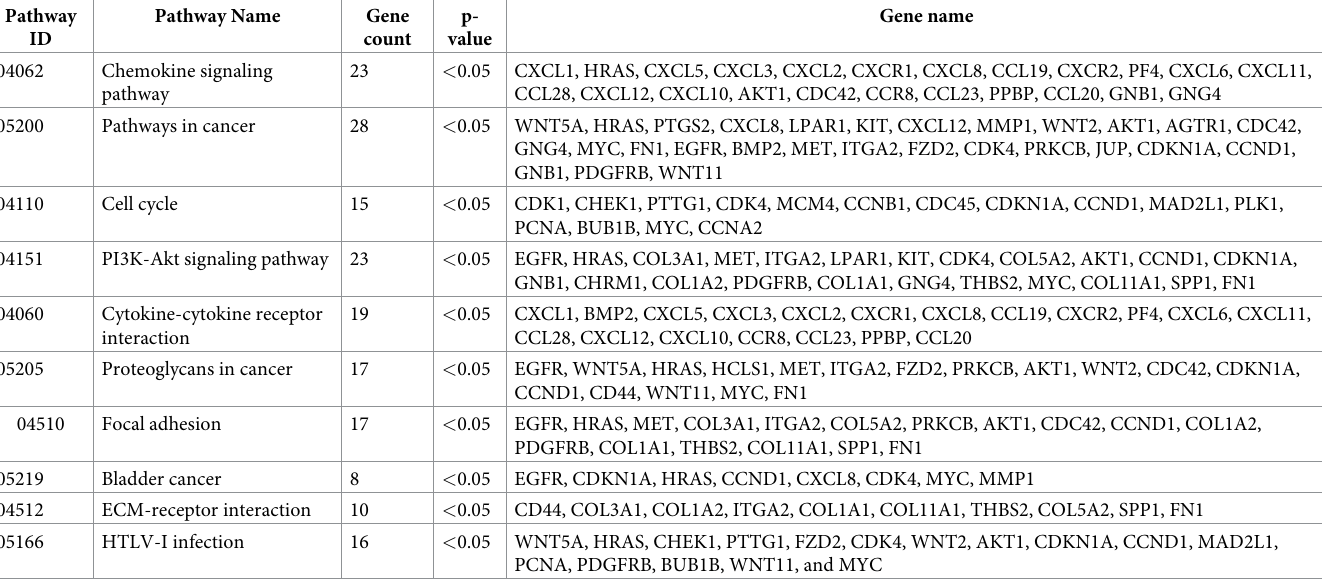
Table 2. KEGG pathway analysis details of the 210 pooled hub genes, extracted from the various GEO microarray CRC expression datasets. Pathway